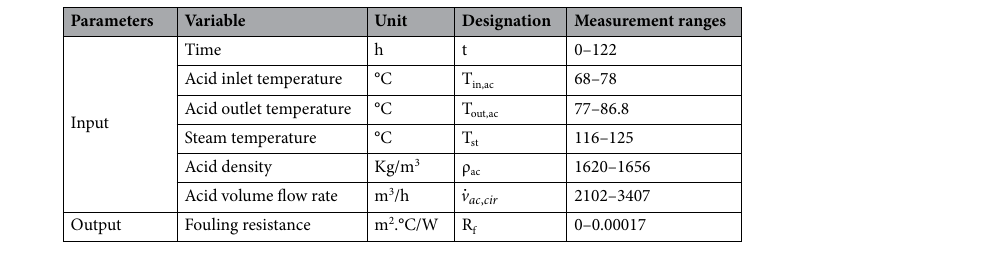
Table 5. Input and output parameters used by ANN